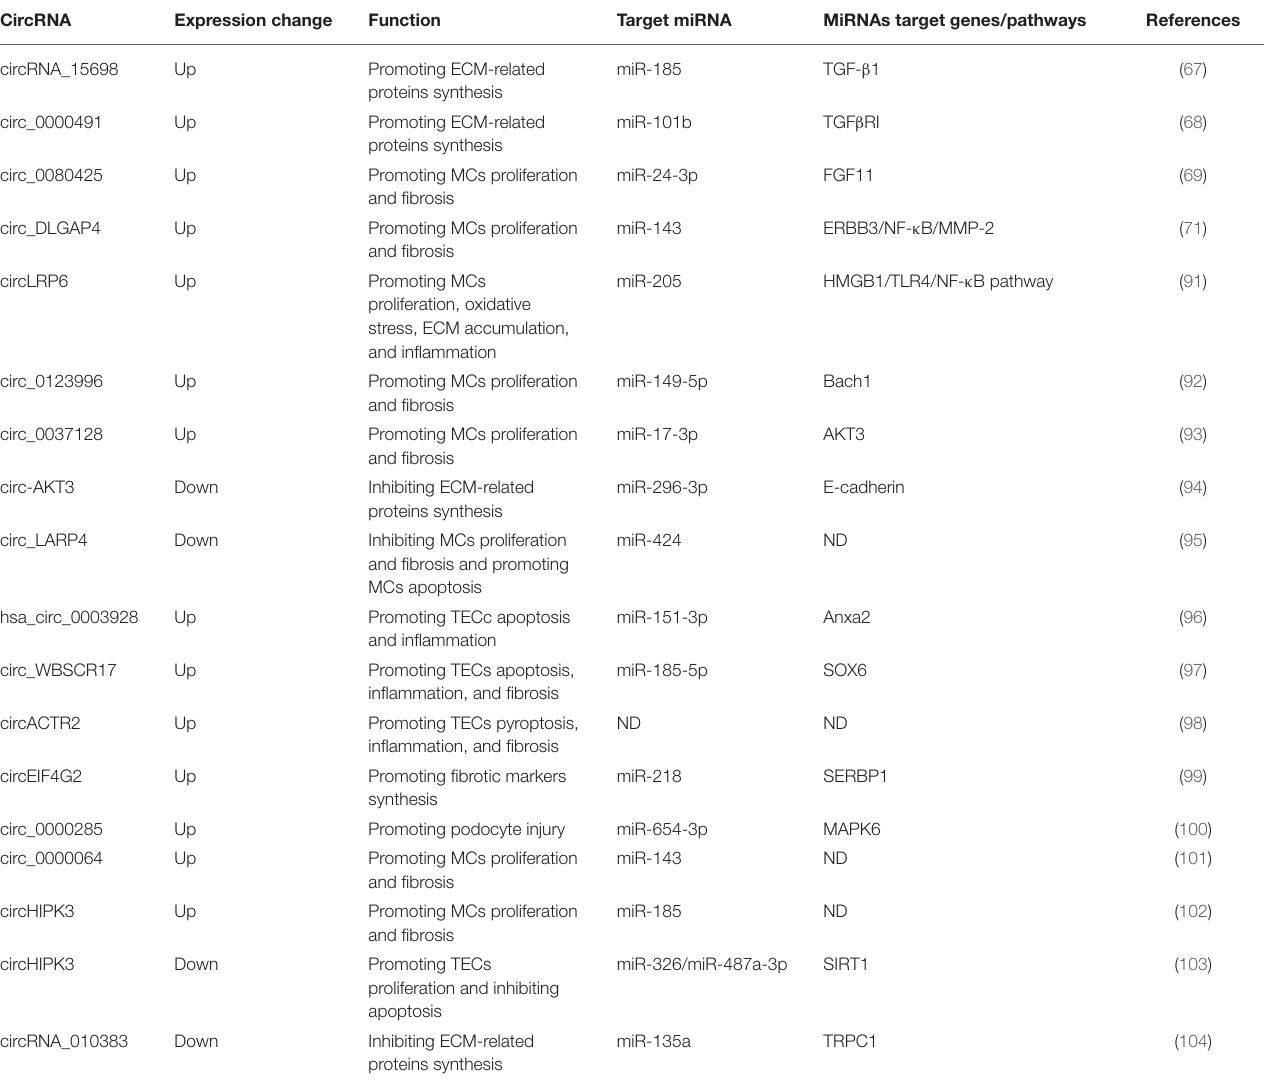
TABLE 3 | Summary of candidate circRNAs as therapeutic targets in diabetic kidney disease (DKD).